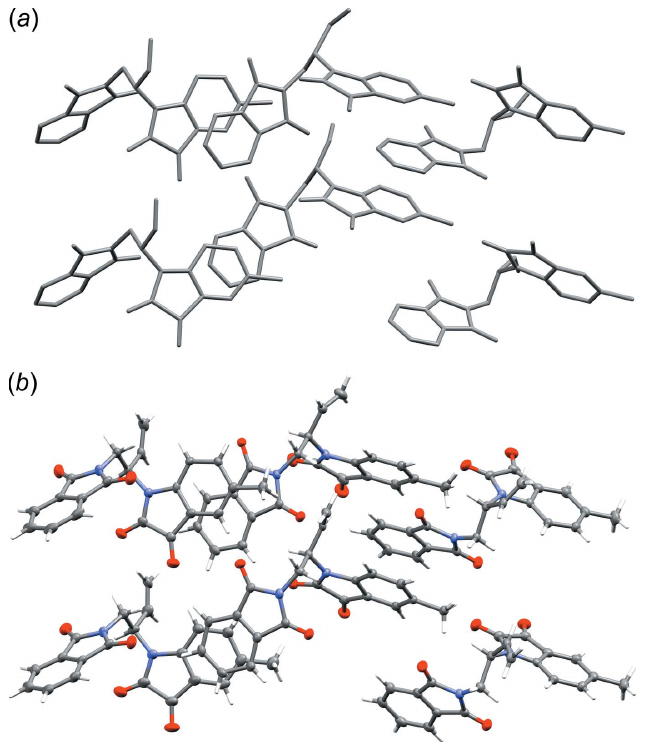
Figure 9 ( a ) Structure solution using B 2 1 , Z 0 = 6 for WUGLES, all non-hydrogen atoms are present. ( b ) The B 2 1 , Z 0 = 6 structure with hydrogen atoms and after full anisotropic refinement and assignment of absolute configura- tion. Diagrams generated using Mercury (Macrae et al. ,